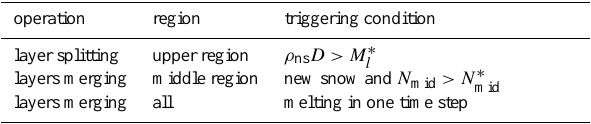
Table D1. Definition of snow discretisation regions. Case Upper Middle Bottom